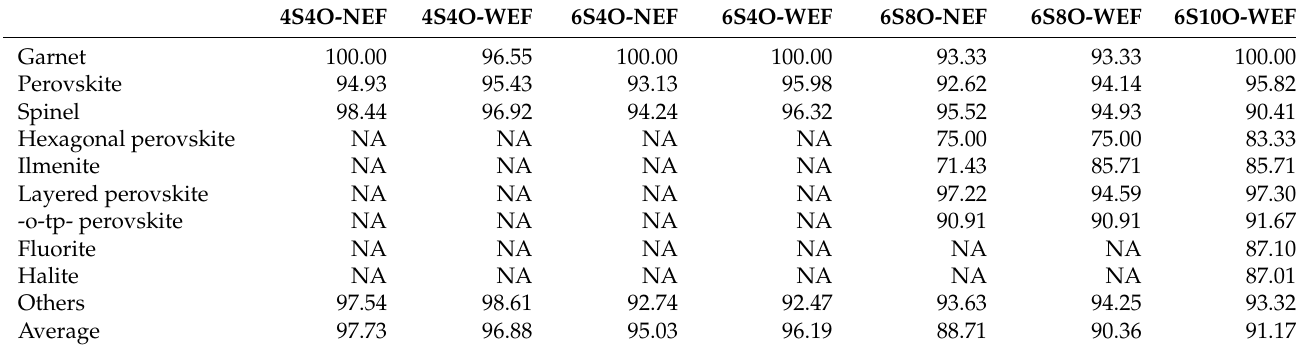
Table 2. Precisions in the classifications of the structure types (first column) achieved by each ANNs (from second column to the last) after the compounds of the test